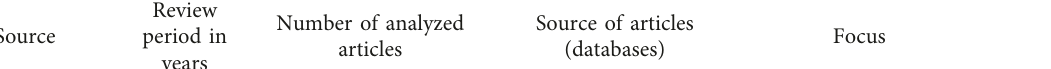
Table 1: Summary of major review studies on BIM for civil